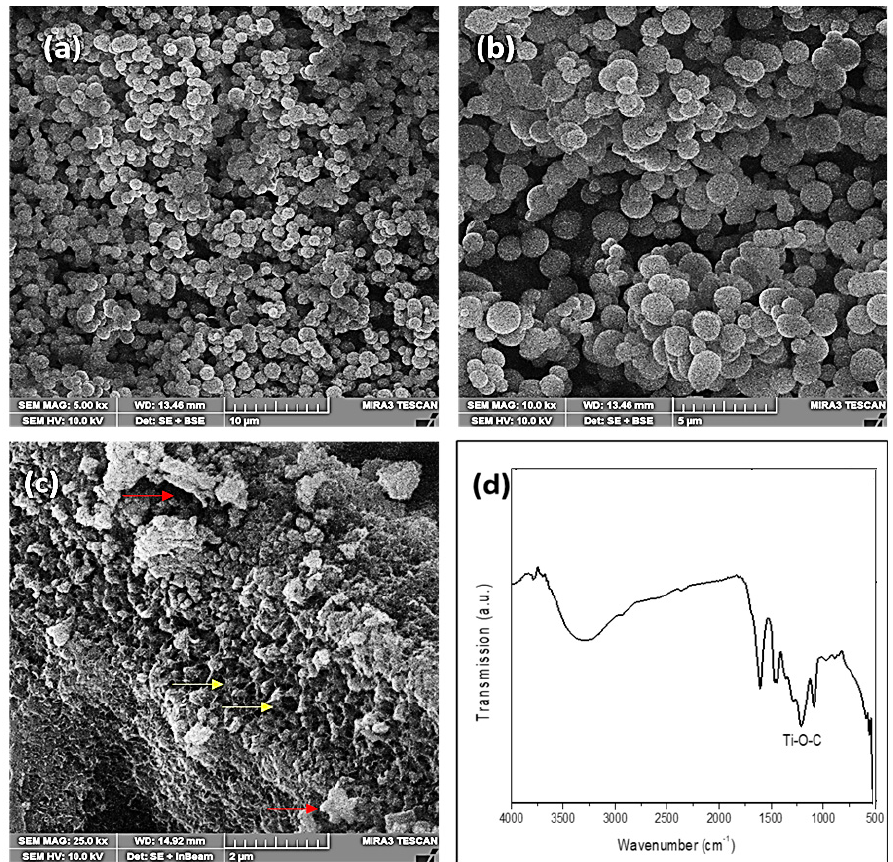
Figure 1. ( a – c ) FESEM micrographs (contrast altered) at different magnifications and ( d ) FTIR spectrum of CXTi synthesised in this study.